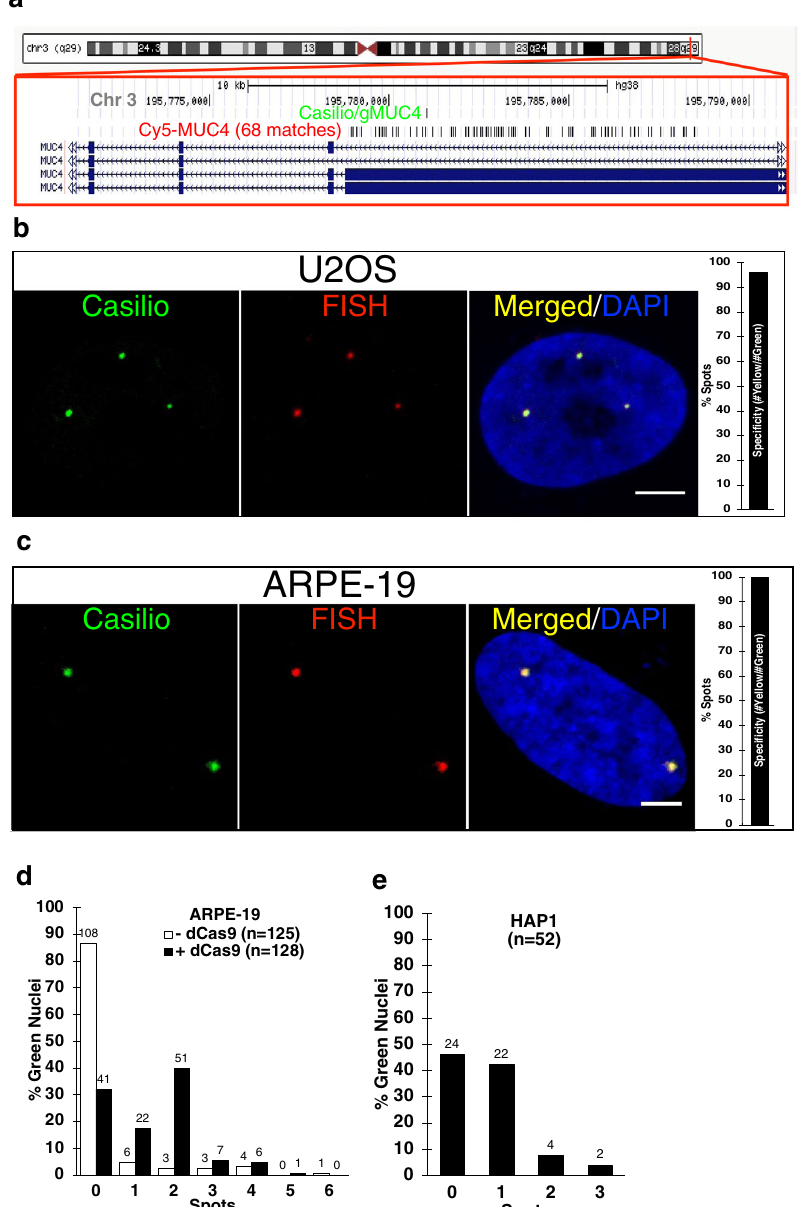
Fig. 2 Validation of Casilio imaging speci fi city. a Schematic showing locations of Casilio MUC4 gRNA (gMUC4) and Cy5-MUC4 FISH probes. Chr, chromosome. b Co-labeling of MUC4 locus by Casilio (Green) and DNA-FISH (Cy5-MUC4, Red) in U2OS cells ( n = 8 nuclei; 28 spots; Speci fi city = #Red- Green-overlap/#Green = 96%). Scale bar, 5 μ m. c Co-labeling of Casilio (Green) and DNA-FISH (Cy5-MUC4, Red) in ARPE-19 cells ( n = 16 nuclei; 40 spots; Speci fi city = 100%). Scale bar, 5 μ m. d Percentage of green ARPE-19 nuclei with the indicated numbers of Casilio/gMUC4 spots in live cells without and with dCas9. Nucleus counts are indicated on top of the columns. e Percentage of green HAP1 nuclei with the indicated numbers of Casilio/ gMUC4 spots in live cells. Nucleus counts are indicated on top of the columns. Source data are provided as a Source Data fi (Fig. 4c; Supplementary Video 3; Supplementary Figs. 2c, 5). (Fig. 4e). Consistent with the observation obtained by sequencing Depletion of RAD21 led to farther pairwise distances of the Casilio experiments, pairwise distances of Casilio spots decreased upon spots in cells treated with auxin compared to the untreated control, auxin-mediated RAD21-depletion, with medians of 1.24 μ m and with medians of 2.09 μ m and 1.21 μ m, respectively (Mann – Whitney 0.57 μ m, respectively (Mann – Whitney two-sided p -value = 1.81 × two-sided p -value = 1.69 × 10 − 53 ) (Fig. 4d), consistent with the 10 − 108 ), for the untreated and auxin-treated cells (Fig. 4f – h; reduced interaction between the promoter and super enhancer of Supplementary Videos 4, 5; Supplementary Fig. 2d, e). IER5L upon RAD21 depletion 29 . We also used Casilio to image a These data demonstrate that Casilio can image interaction “ RAD21-independent ” interaction connecting two H3K27ac- between cis-regulatory elements to study the contribution of enriched super-enhancers and displaying an opposite behavior, in protein factors, such as cohesin, on dynamic chromatin which interaction frequency increased upon RAD21 depletion 29 interactions underlying gene regulation.